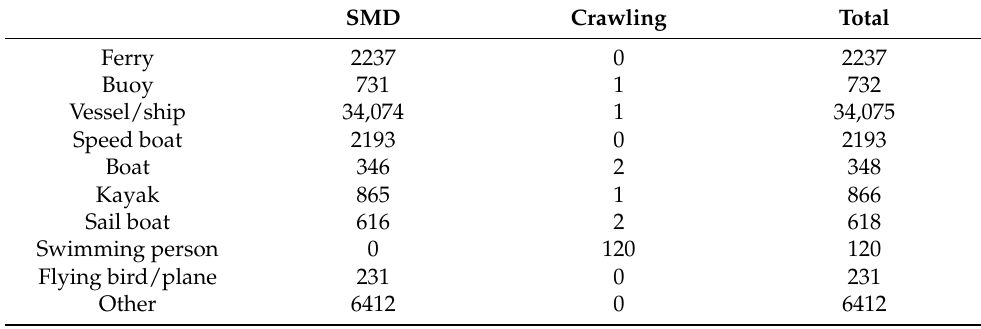
Table 1. Number of objects per class for all images.